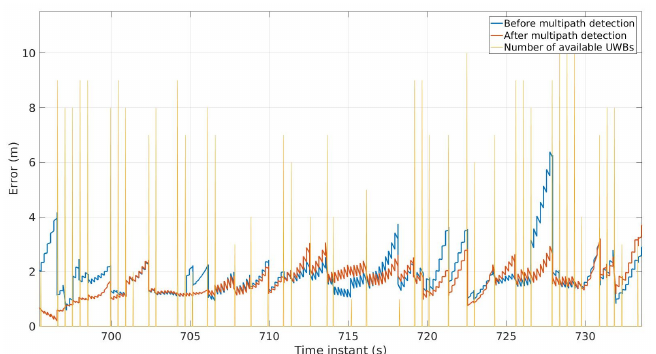
Figure 19. View4: Zoomed view of Figure 17.